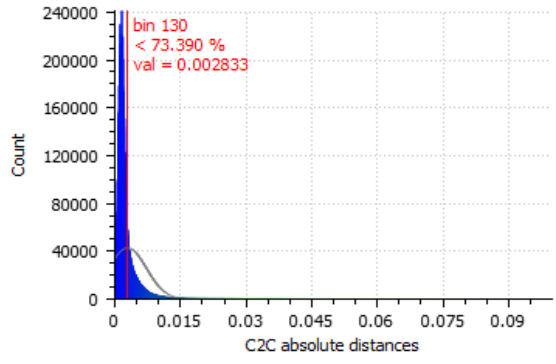
Figure 8. Gauss Distribution for cloud to cloud absolute distances